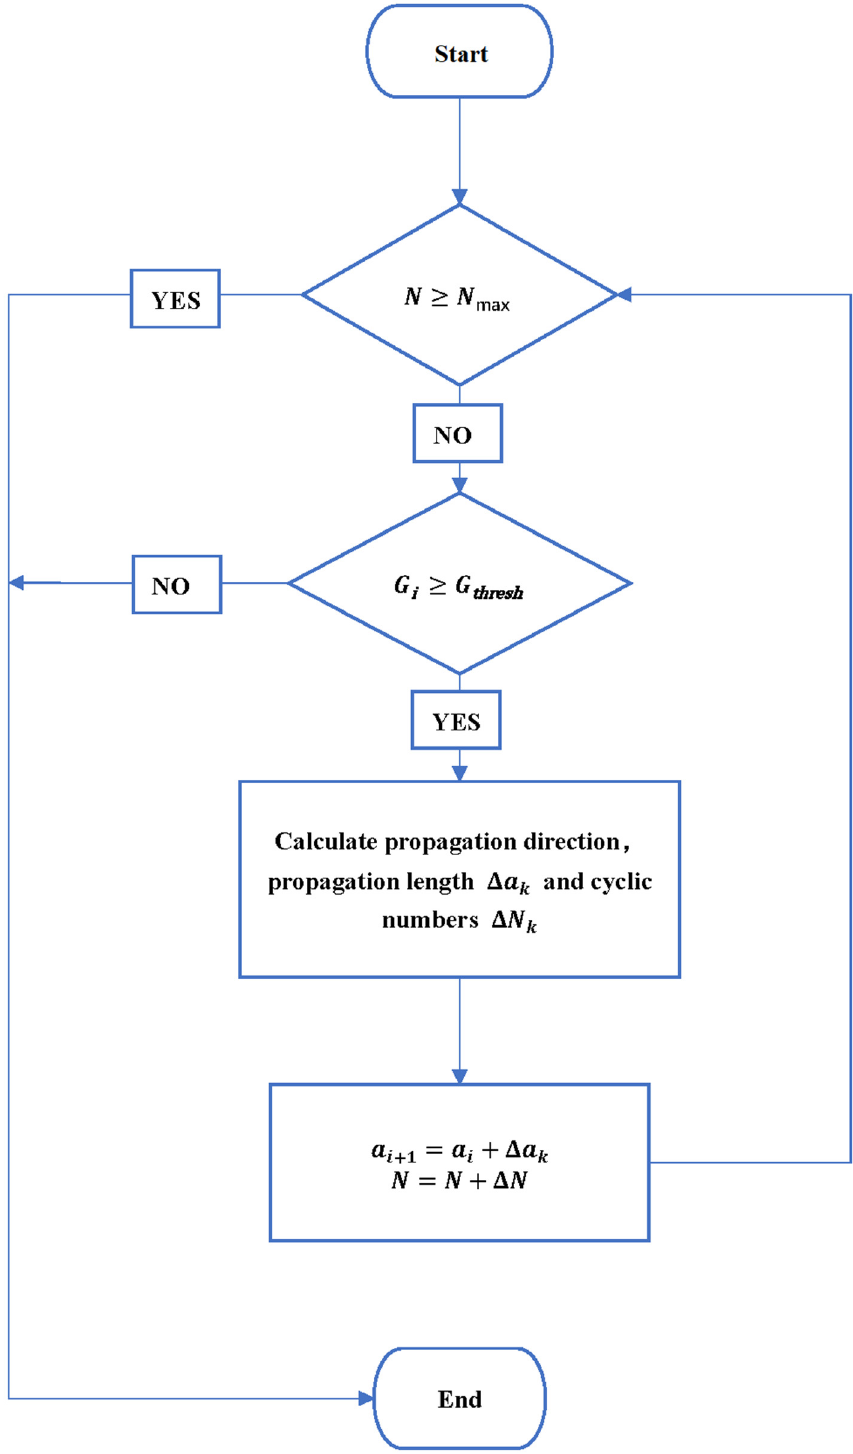
Figure 12. Illustration of XFEM propagation progress.